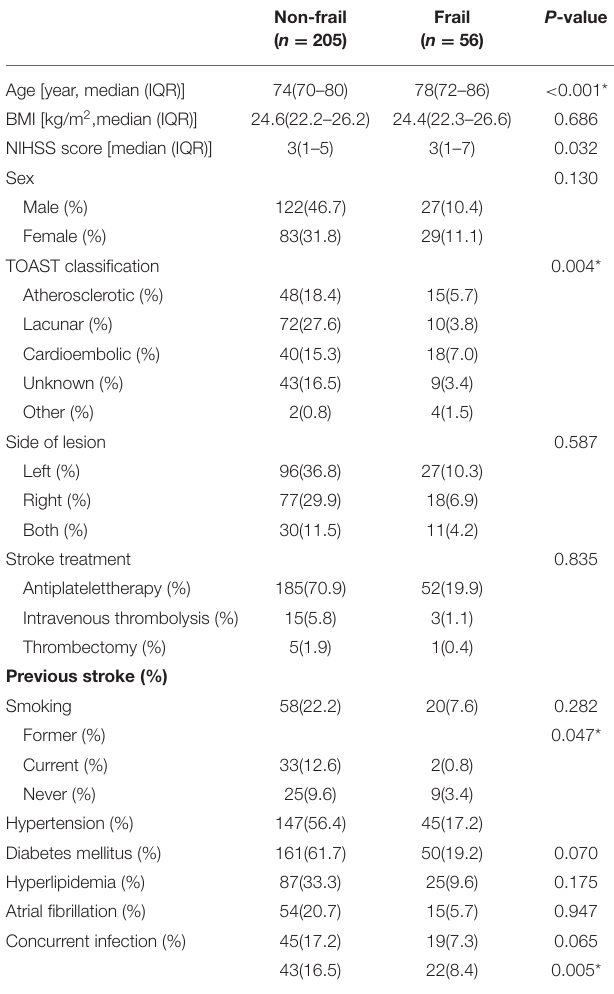
TABLE 1 | Demographics and clinical characteristics of the participants for survival